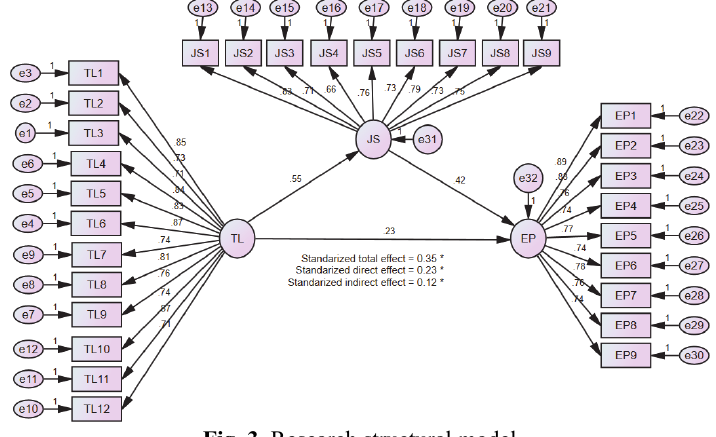
Fig. 3. Research structural